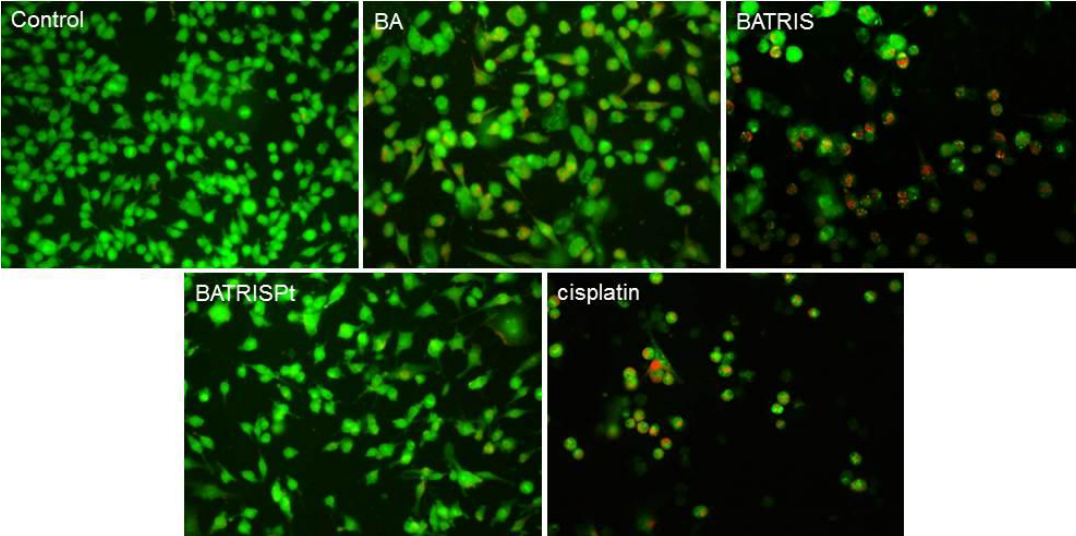
Figure 2. Morphological and apoptosis evaluation of B16 cells (untreated and treated).